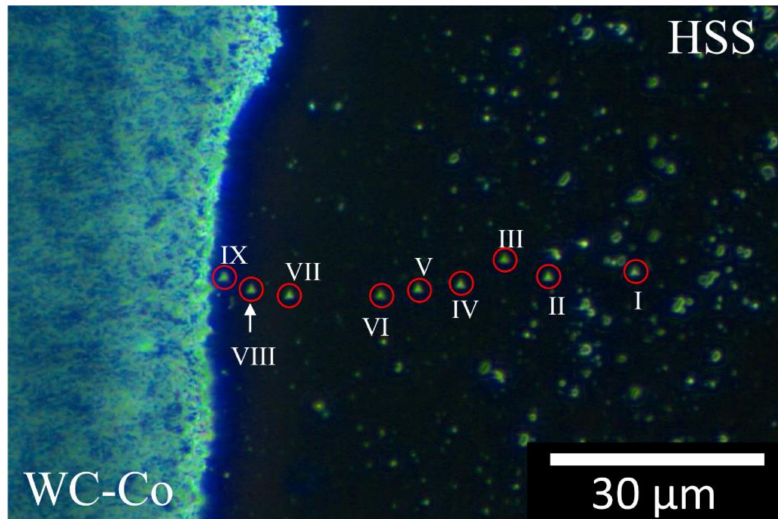
Figure 18. Dark Field Optical Microscopy image of an nIIT linear profile across the weld-line. Here the transitional layer is wide, that is, about 50 µ m, as in Figure 9 (black arrow). The red circles and Roman numerals indicate nine (out of eleven) nano-indentation imprints on the HSS side; it should be pointed out that the profile continues on the WC-Co side, but it is not possible to discern the inherent nano-indentation imprints by means of OM.